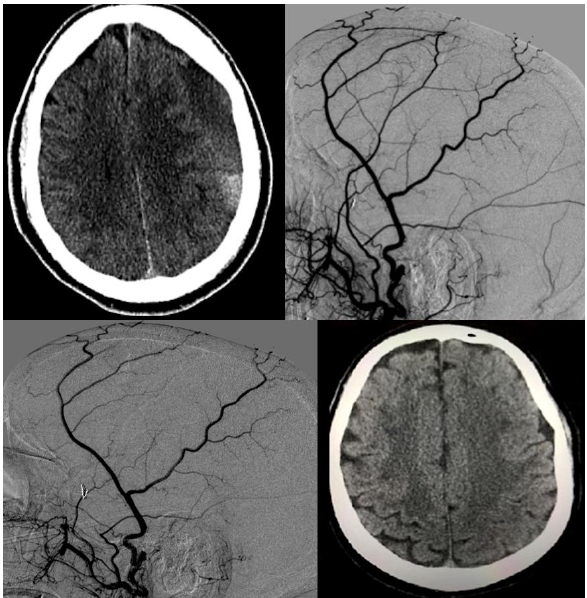
Figure 2. A 68-year-old man with medical history of hypertension and chronic non-valvular atrial fibrillation on coumadin had a minor motor vehicle accident with whiplash injury but no loss of consciousness. Post-trauma emergent non-contrast CT (NCCT) of the head revealed no evidence of subdural hemorrhage. Patient was asked to resume his normal activities as well as continue with anticoagulation regimen. Three weeks later while vacationing in another state, the patient developed subtle speech difficulties, gait disturbance as well as occasional memory lapses. Emergent NCCT was done which revealed bifrontal subdural hematoma ( left worse than right ) with acute on chronic component and midline shift. He underwent bifrontal burr hole surgeries but had a fresh re-hemorrhage a week later. The patient flew back to home state where another NCCT was prompted by clinical worsening, including coordination difficulties and word-finding difficulties. This revealed significant worsening from acute on chronic SDH as well as midline shift ( top left ). Patient was taken for emergent MMA embolization, and the images shows pre-embolization ( top right ) and post-embolization ( bottom left ) angiograms. Patient then had monthly clinical and radiological (NCCT) follow-ups. Anticoagulation was stopped throughout this period. Four months later, the patient had near resolution of his SDH after which antiplatelets were started. After another month, anticoagulation was started. The last control NCCT was done 3 months after resumption of anticoagulation and is shown in the image on the bottom